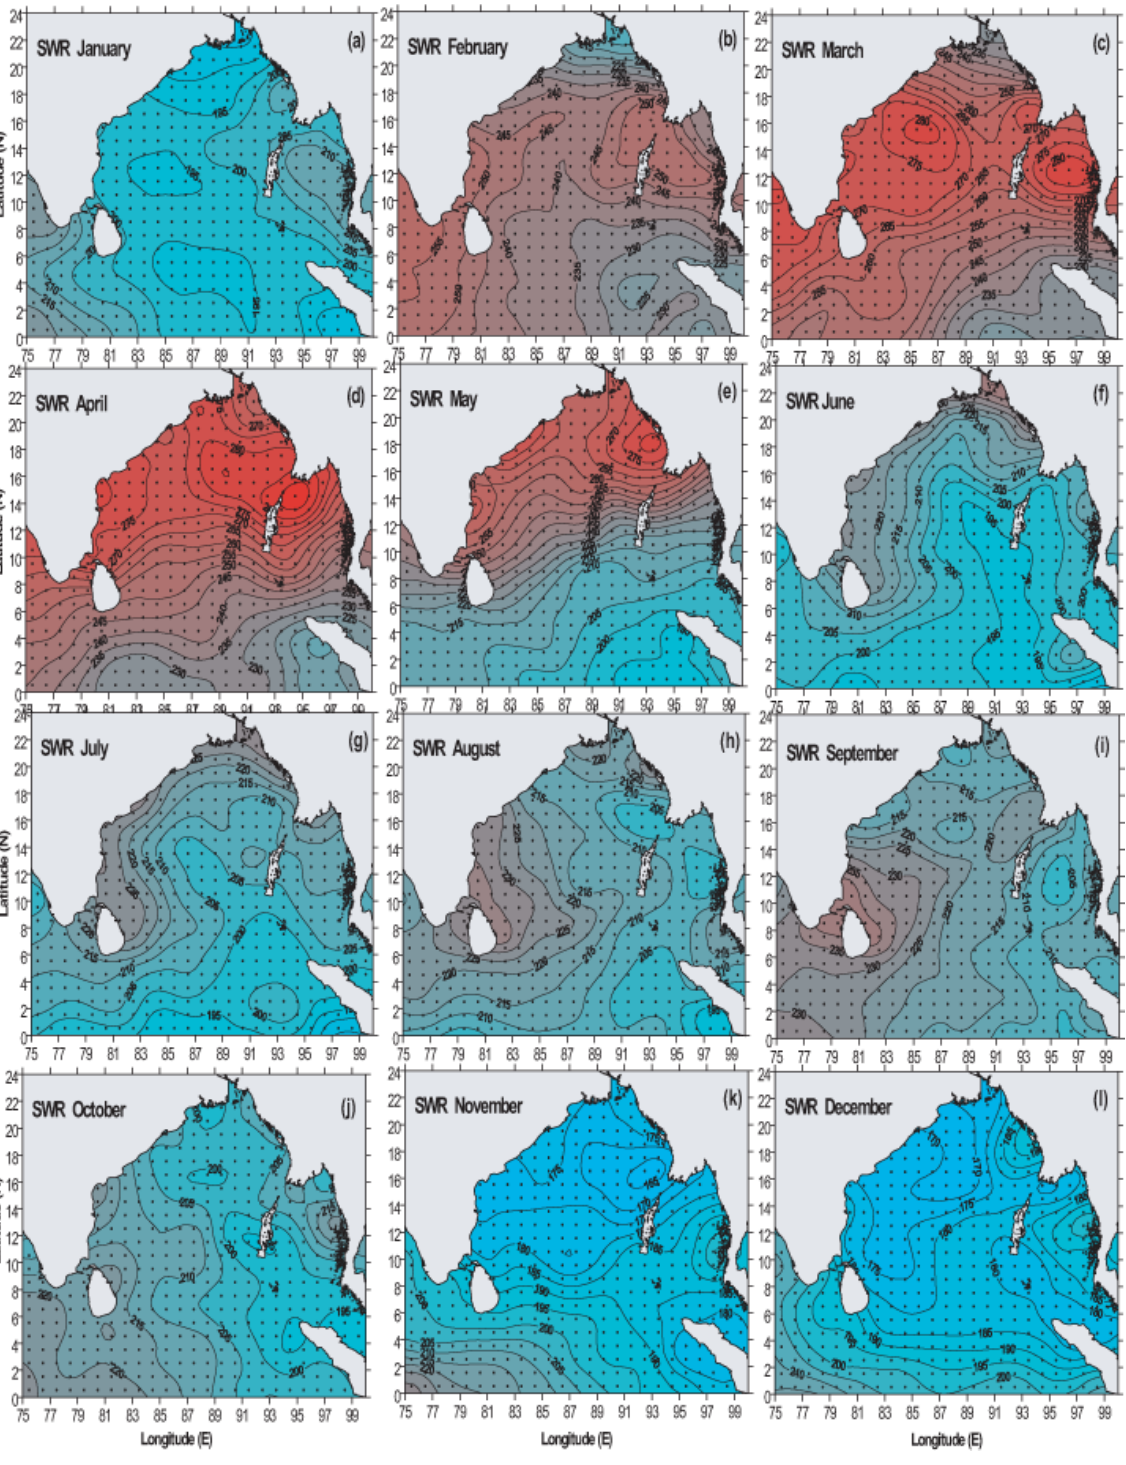
Figure A4. Monthly mean climatology of incoming short wave radiation (SWR, Wm − 2 ) from January to